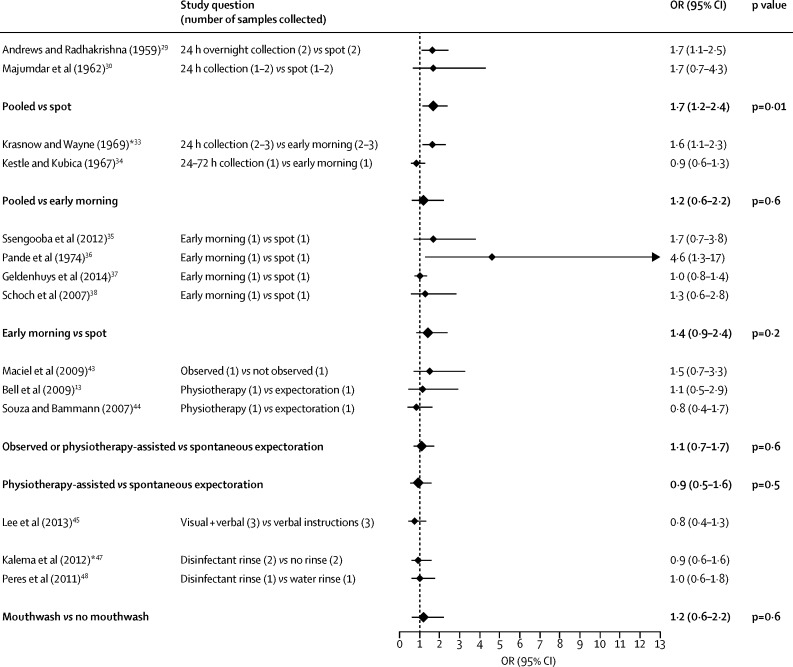
Forest plot of both individual and combined meta-analysis results for mycobacterial culture*Odds ratio (OR) was calculated from individual patient-level data and not from sputum sample-level data. Comparisons in bold typeface and a larger diamond symbol indicate the results of a pairwise meta-analysis.